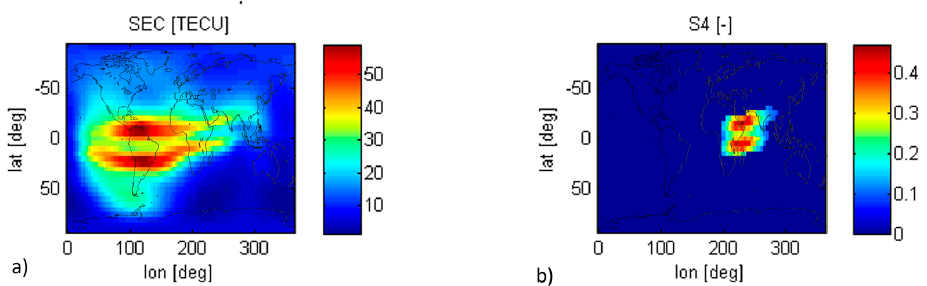
Figure 3. ( a ) Slant Electron Content maps in [TECU] computed with GISM for, and associated, ( b ) Scintillation Index S 4 maps for paths for a receiver on ground. UT = 6 AM.